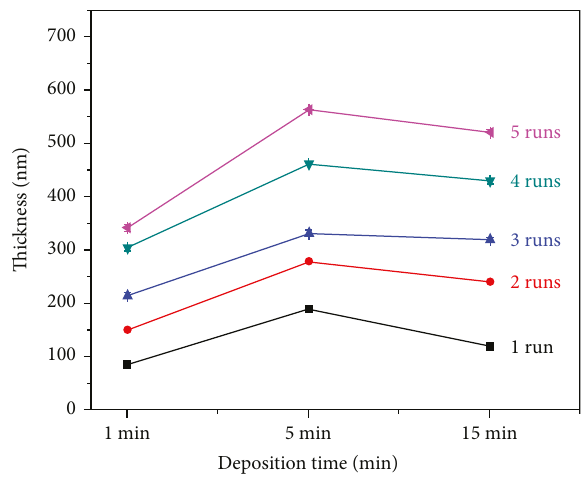
Figure 6: Variation of the fi lm thickness as a function of the number of runs and deposition